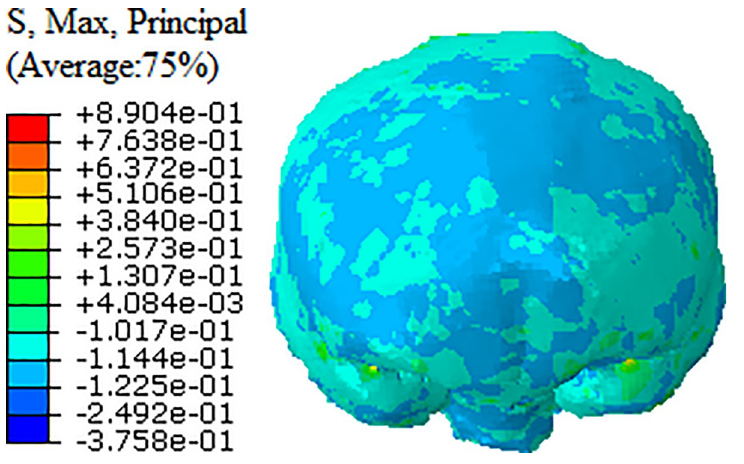
Fig 17. Strain of frontal brain tissue.